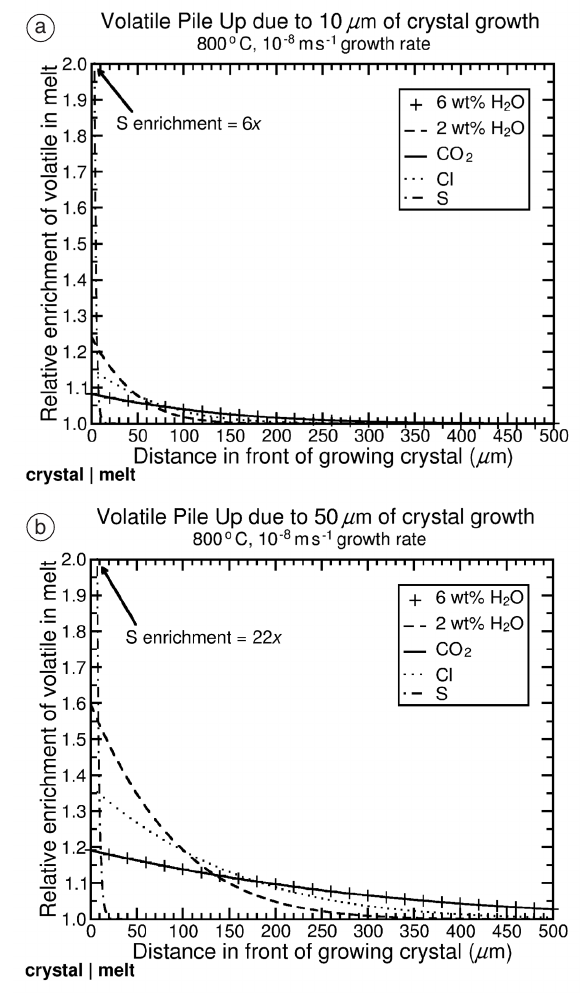
Fig. 7a,b. Volatile concentration enrichment profiles in front of a crystal growing in a rhyolitic melt at 800°C. The diffusion coefficients for volatiles are from fig. 5 and the sources of the crystal growth rates are discussed in the text. Note that composition enrichment profiles for 6 wt% H 2 O and CO 2 plot on top of one another because their diffu- sion coefficients are identical at the conditions studied (see fig. 5). The effects of crystal growth on volatile concen- tration enrichment profiles relative to the concentration at infinite distance near the crystal-melt interface are mod- elled at a growth rate of 10 − 8 ms − 1 for a total growth of 10 µ m (a), 50 µ m (b). Further discussion is found in the